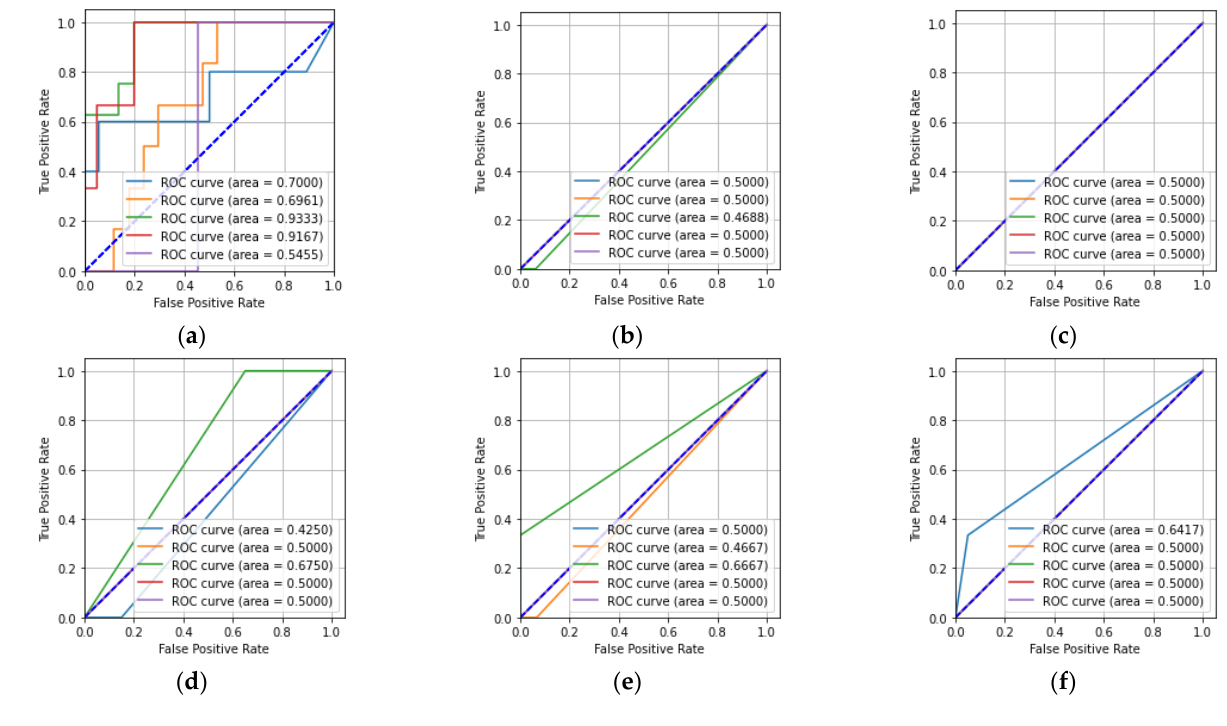
Figure 17. ROCs for the phase-only image dataset: ( a ) CNN; ( b ) KNN; ( c ) MLP; ( d ) DT; ( e ) RF; ( f ) ET.